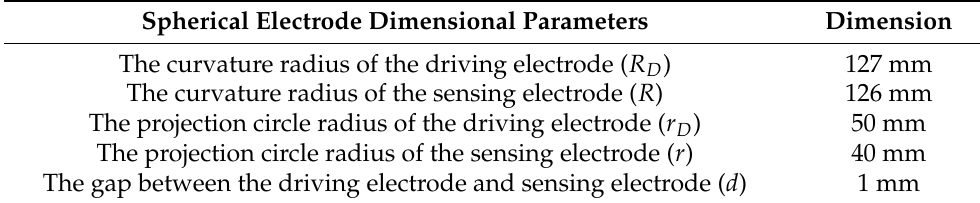
Table 2. Dimensions of parameters of the prototype